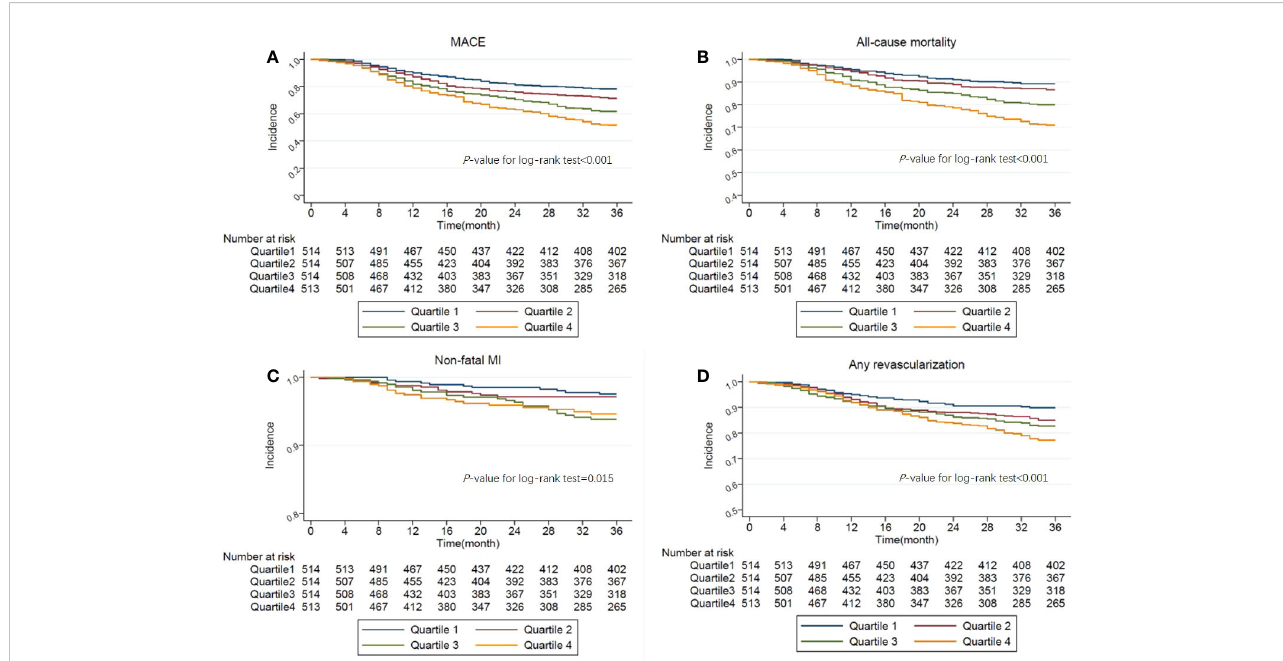
FIGURE 2 (A) . Kaplan-Meier curves showing the association between the TyG quartiles and MACE. (B) . Kaplan-Meier curves showing the association between the TyG quartiles and All-cause mortality. (C) . Kaplan-Meier curves showing the association between the TyG quartiles and Non-fatal MI. (D) . Kaplan-Meier curves showing the association between the TyG quartiles and Any